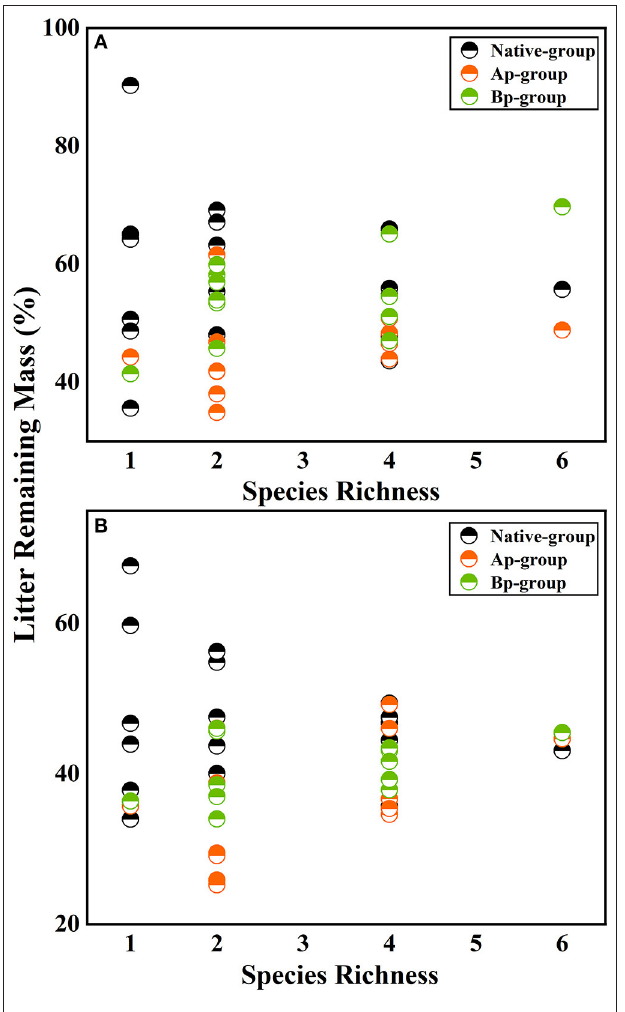
FIGURE 3 | The litter remaining mass at different rates for different levels of species richness in the hydro-fluctuation zone (A) and terrestrial zone (B) . The Ap-group indicates litter mixtures of A. philoxeroides and native species, and the Bp-group represents litter mixtures of B. pilosa and native species. Data are expressed as mean values.